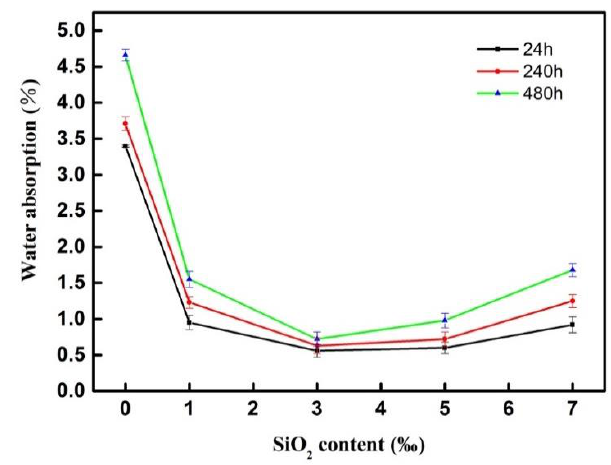
Figure 5. Water absorption of BF epoxy resin coatings.